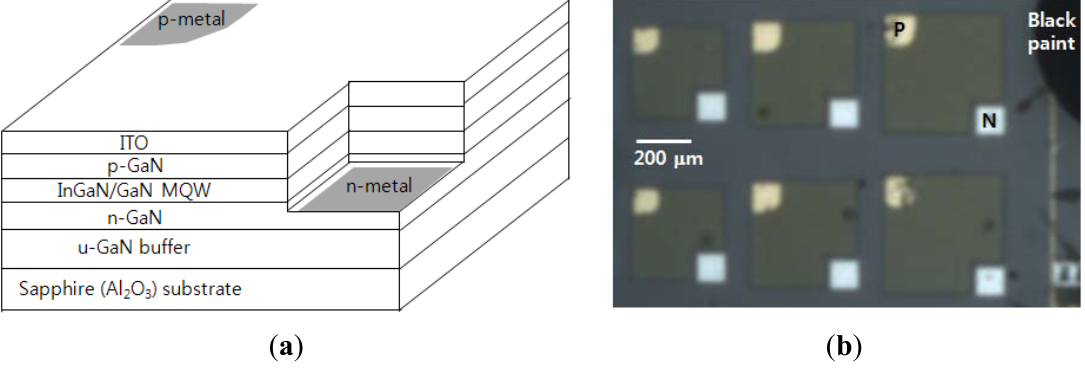
Figure 2. ( a ) Schematic diagram of the InGaN/GaN MQW green LED structure with lateral electrode. ( b ) Top view of optical microscope image of the fabricated LED wafer under